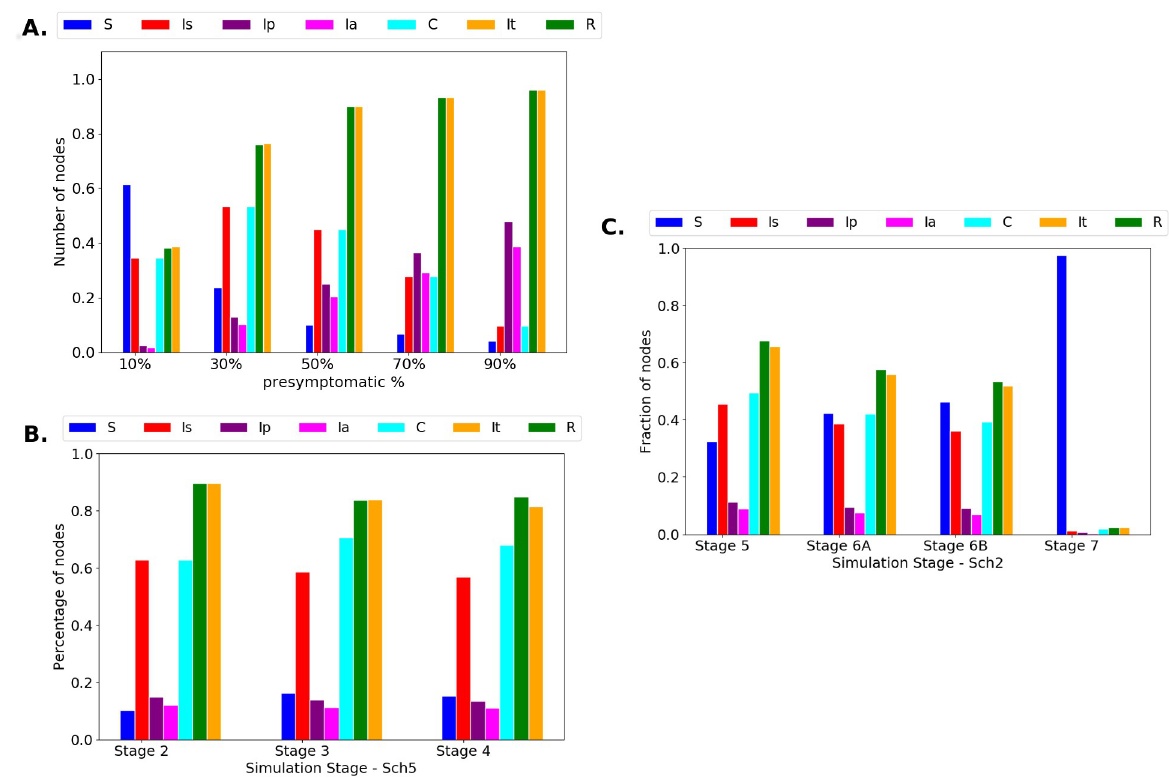
Fig 4. A . Sch7 on Stage 2. In this case, the percentage of nodes (or agents) on states Ip and Ia increases, and agents in state Is are confined. Then, the spread of the disease increases due to agents in states Ip and Ia that are not detected and confined. B . Comparing stages 2, 3 and 4 on Sch5 network: In this case, the figure shows the results obtained for Sch5 at each stage (1 to 4). In these cases, 30% of the infected students are not symptomatic, and from these, 45% are asymptomatic. C . Comparing stages 5, 6A, 6B and 7 for Sch2, 30% of the agents were not symptomatic, and from these, 45% were